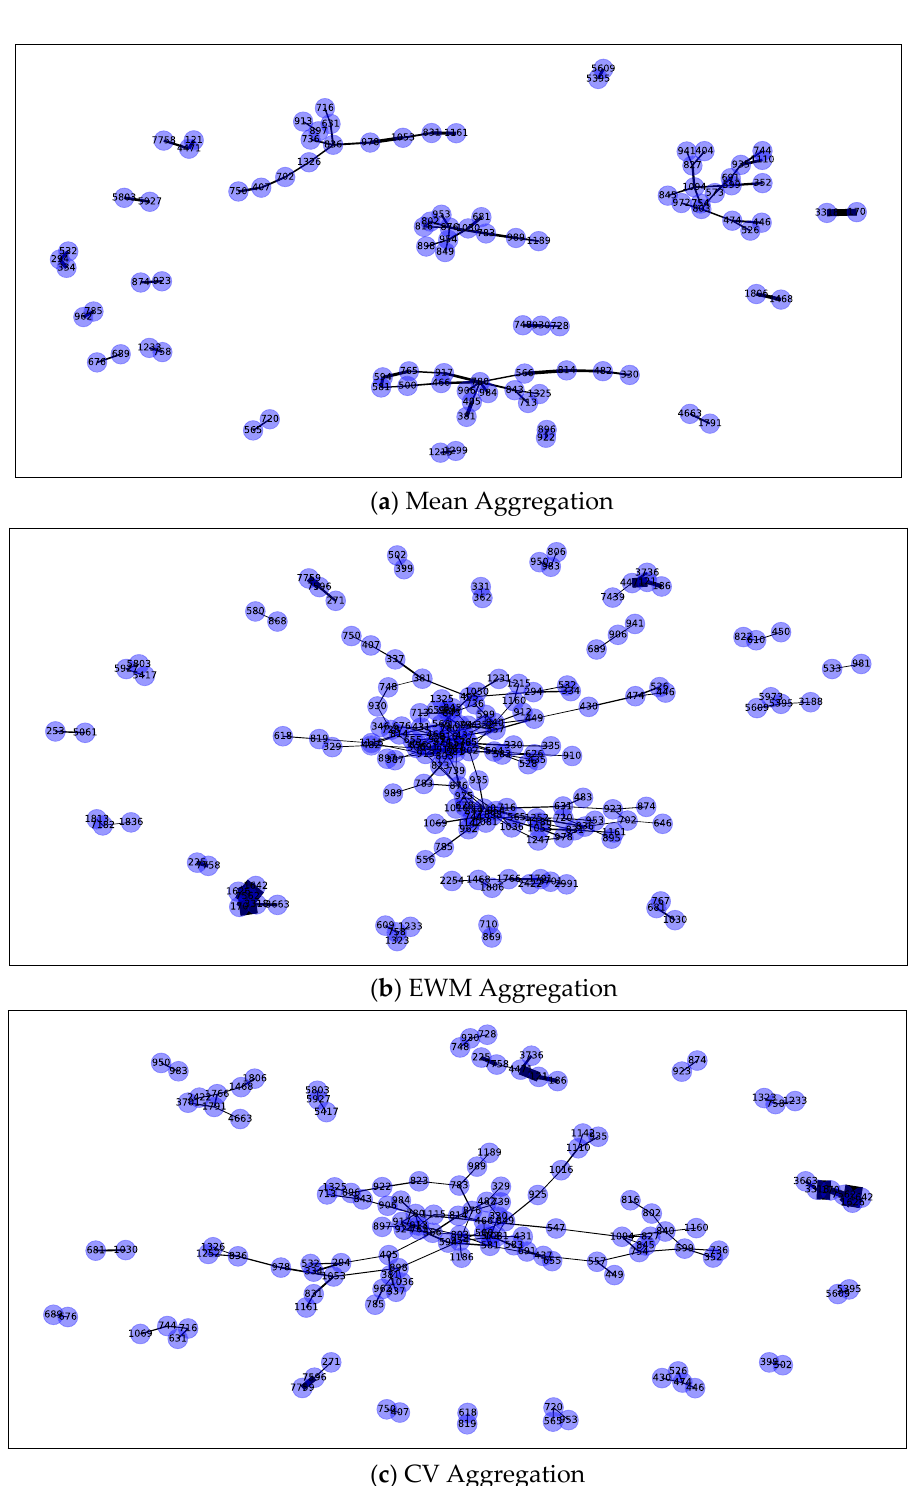
Figure 5. Collusive Groups.